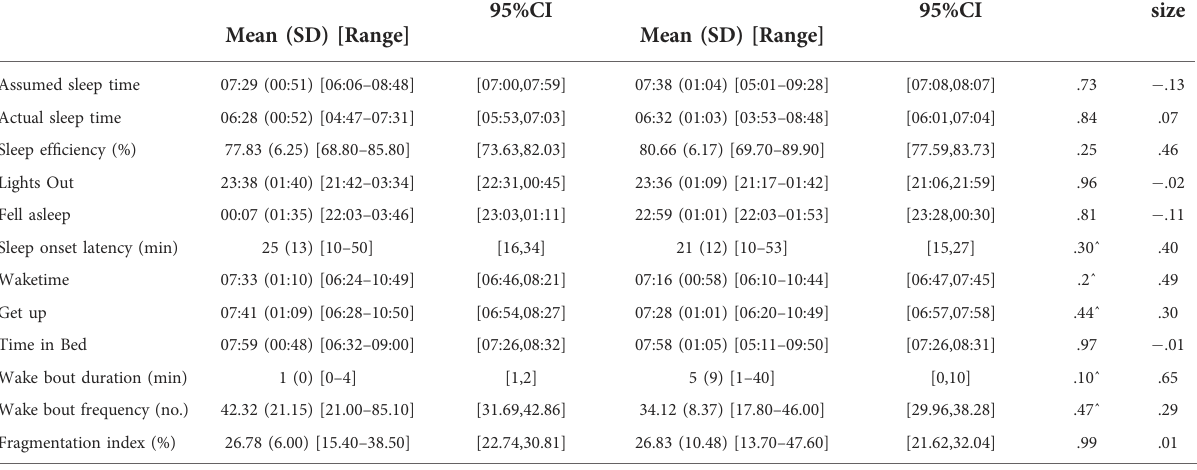
TABLE 6 Sleep pro fi les of mothers according to their cortisol pro fi les based on actigraphy and sleep diary data. Actigraphy variable